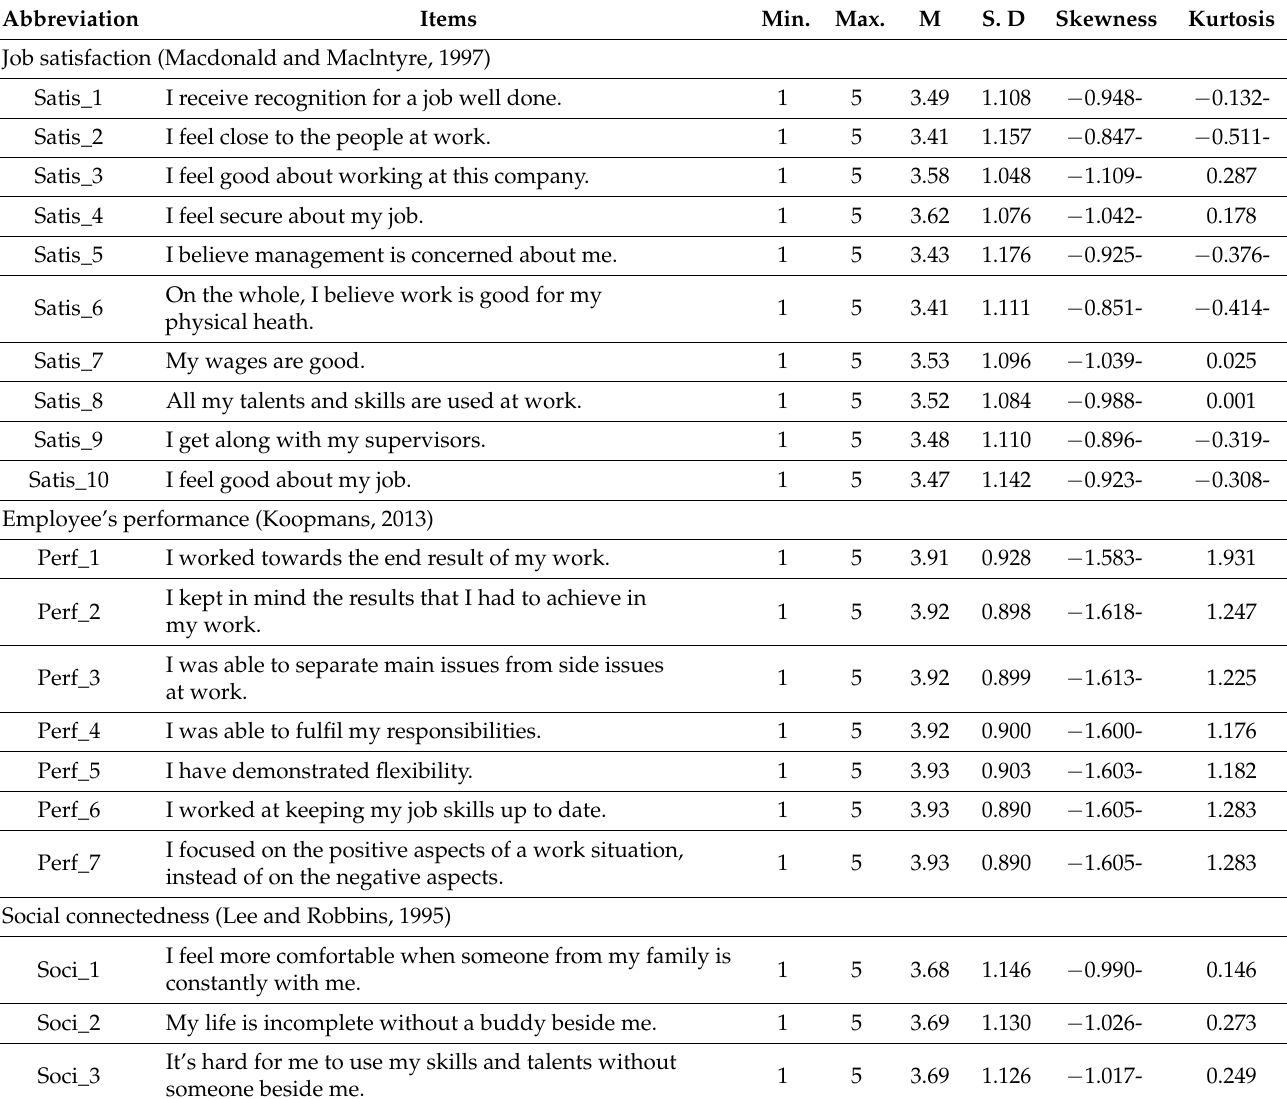
Table 2. Descriptive analysis ( n =